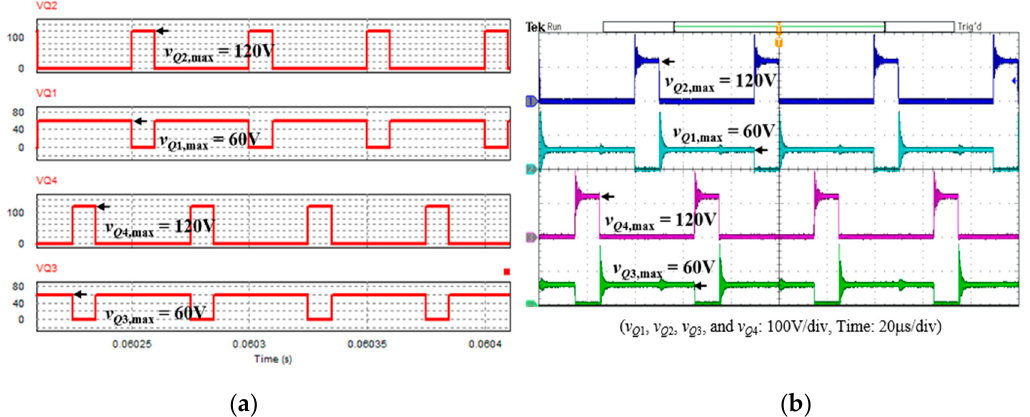
Figure 14. The waveform of switching voltage across the power devices in the UC charge mode with D c = 0.8: ( a ) simulated and ( b ) experimental.